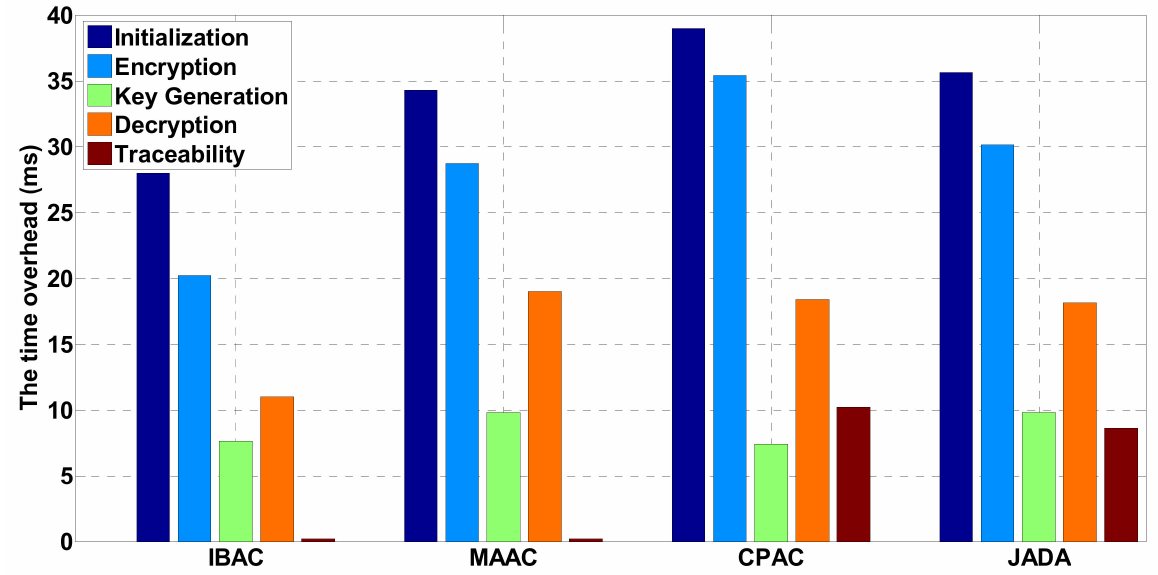
Figure 4. The time overhead of different security management and control schemes in sensor